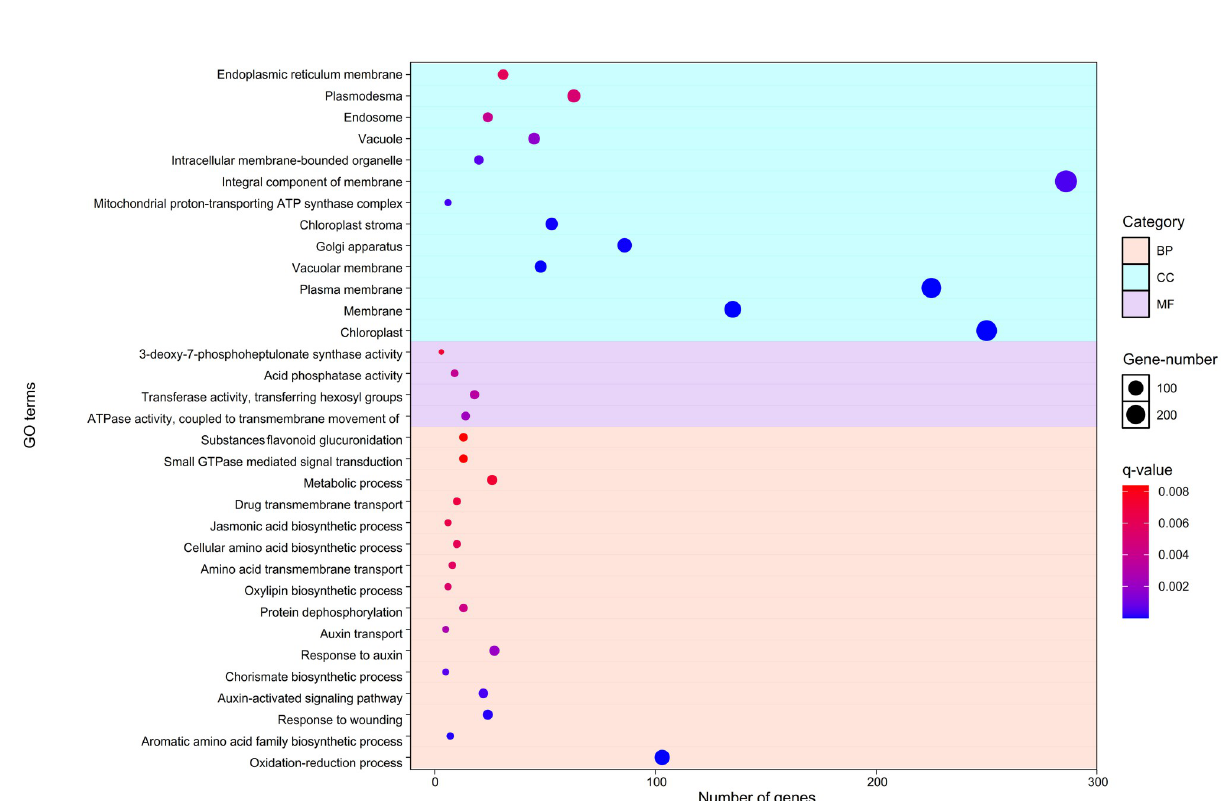
Fig 9. The gene ontology analysis of candidate modules. Gene ontology analysis of candidate modules classified into three functional categories including Biological Process, Molecular Function, and, Cellular Component.